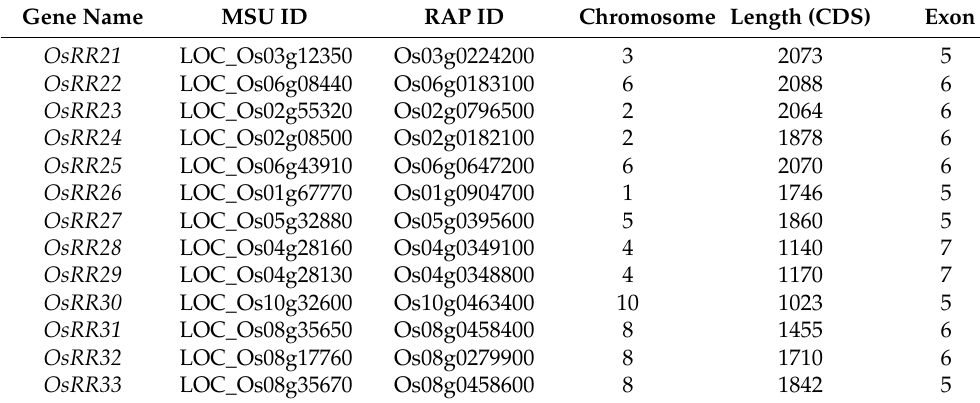
Table 1. Information of type-B OsRRs in